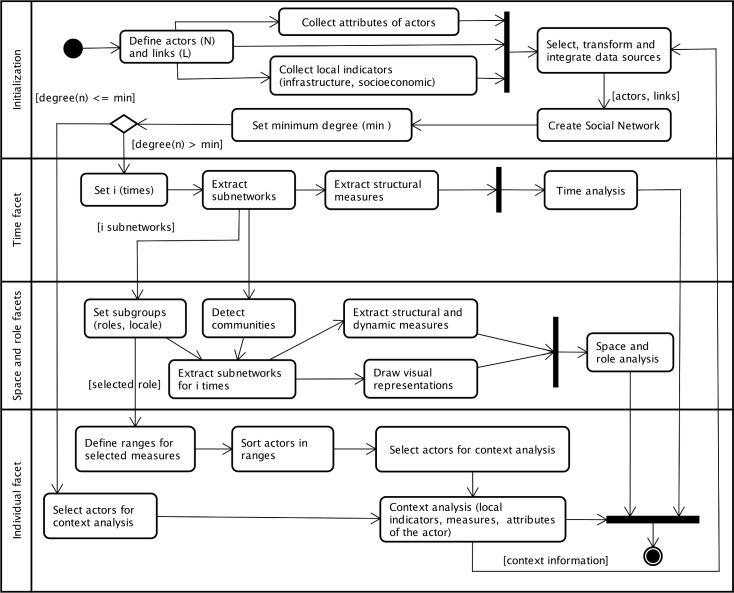
SNA-based Approach for Monitoring ICT Intervention.